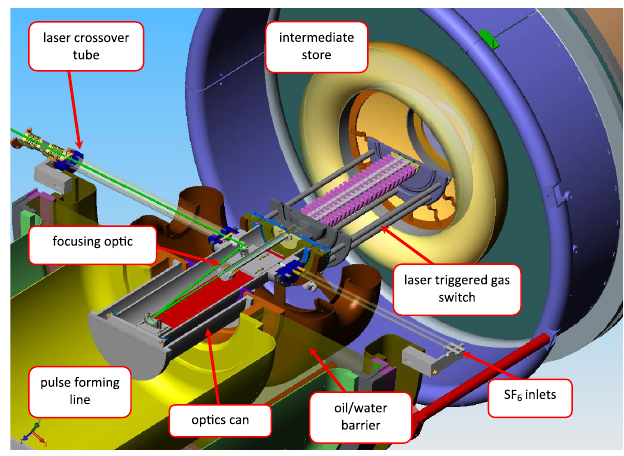
FIG. 13. (Color) Weibull analysis of self-closure data for the modified-Harrison profile utilizing CW70E trigger electrodes.